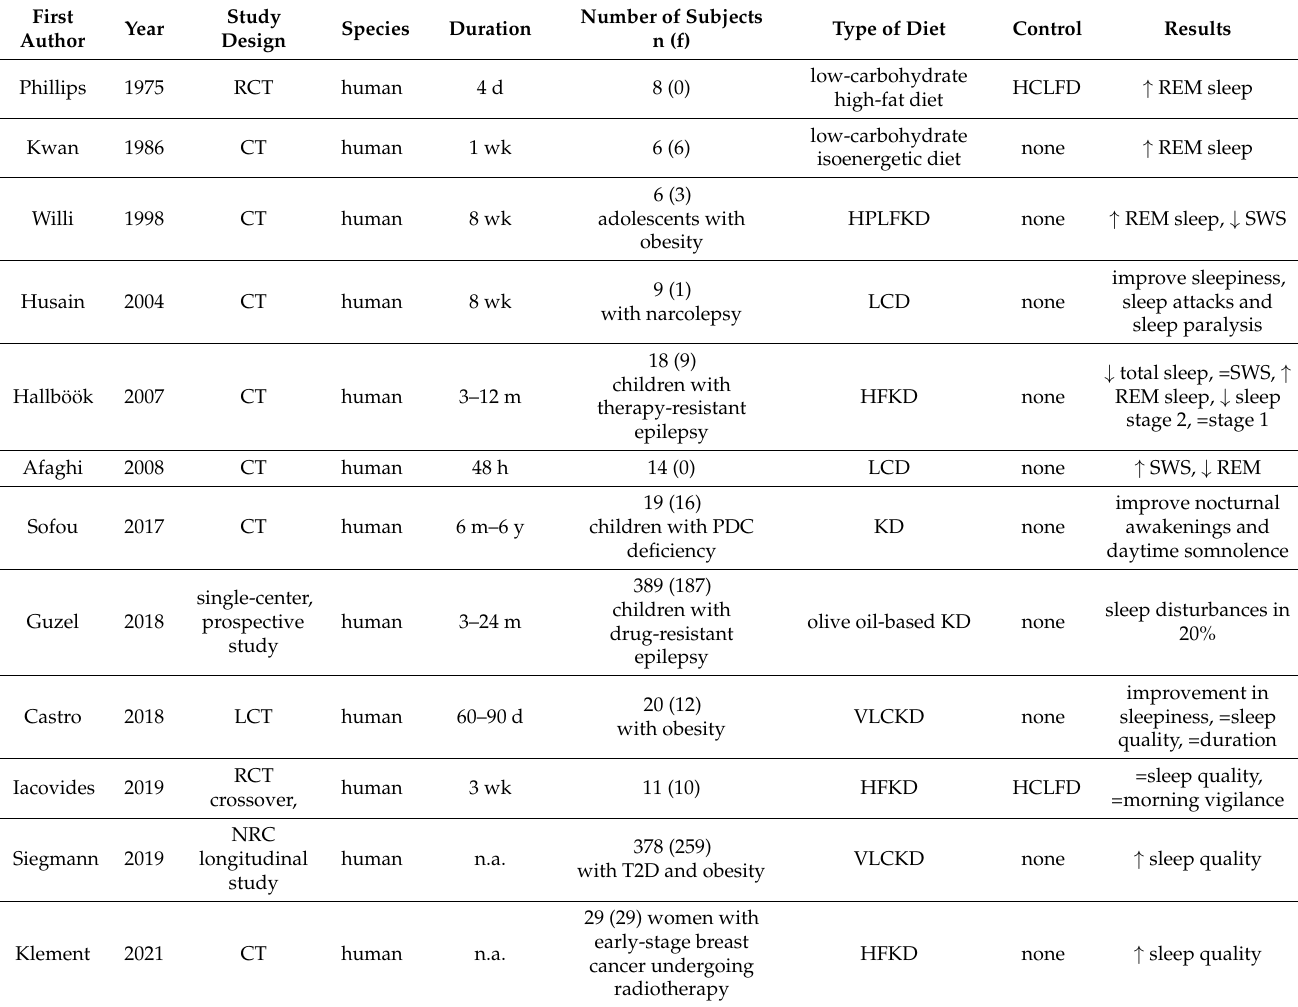
Table 2. Selected studies regarding the effect of a ketogenic diet on sleep